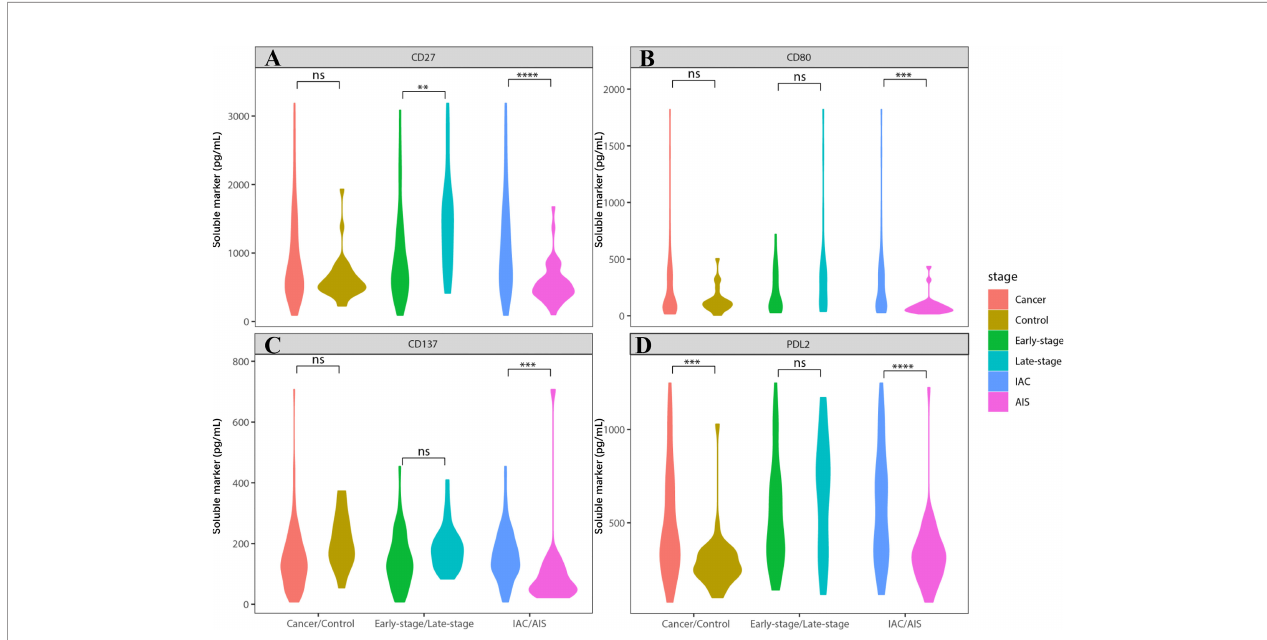
FIGURE 1 | Soluble immune checkpoint-related proteins were associated with lung cancer invasion. Soluble immune checkpoint-related proteins level (sCD27, sCD80, sCD137 and sPDL2) were signi fi cantly increased in IAC patients. (A) sCD27 level was signi fi cantly elevated in IAC patients (vs. AIS patients) ( P =1.05E-06). It was also increased in late-stage IAC patients (vs. early-stage) ( P =2.93E-04). (B) sCD80 level was signi fi cantly elevated in IAC patients, compared to AIS patients ( P =4.44E-05). (C) sCD137 level was signi fi cantly elevated in IAC patients, compared to AIS patients ( P =2.30E-05). It was also increased in late-stage IAC patients (vs. early-stage) ( P =0.02), and controls (vs. cancer) ( P =0.01). However, the data in late-stage and control is not conceivable due to too many missing values. (D) sPDL2 level was signi fi cantly elevated in IAC patients (vs. AIS patients) ( P =1.16E-06). It was also increased in controls (vs. cancer) ( P =1.49E-05). ** indicates P value < 0.01, *** indicates P value < 0.001, **** indicates P value < 0.0001. NS indicates not signi fi